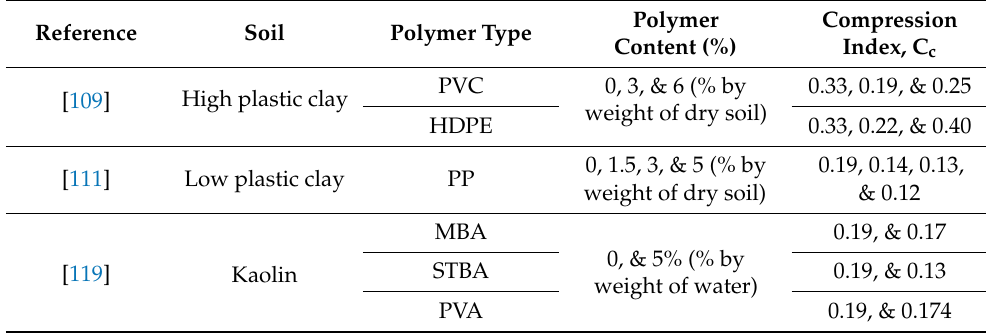
Table 4. Effect of different polymers on the compression index of soil.